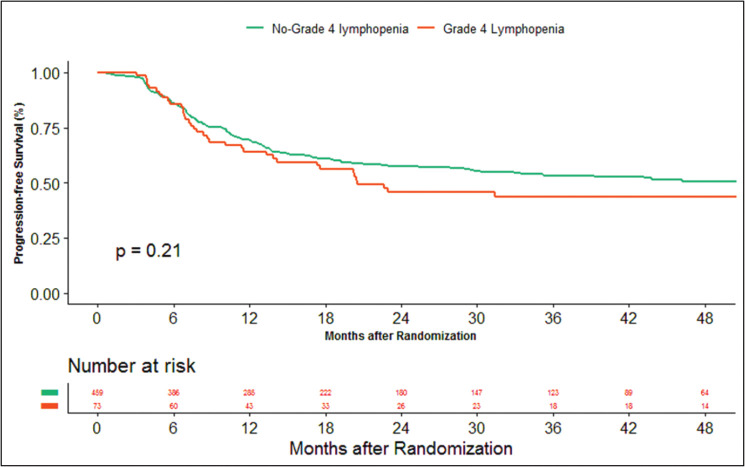
Kaplan–Meier curve showing progression-free survival in grade 4 (severe) and non-grade 4 lymphopenia (non-severe).